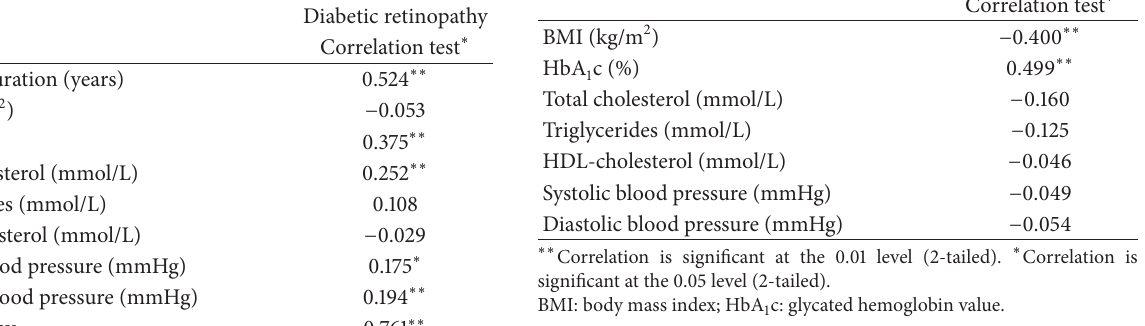
Table 7: Correlation between diabetic retinopathy and diabetes duration, body mass index, and metabolic and clinical parameters in type 1 diabetic patients ( 𝑛 = 176 ).